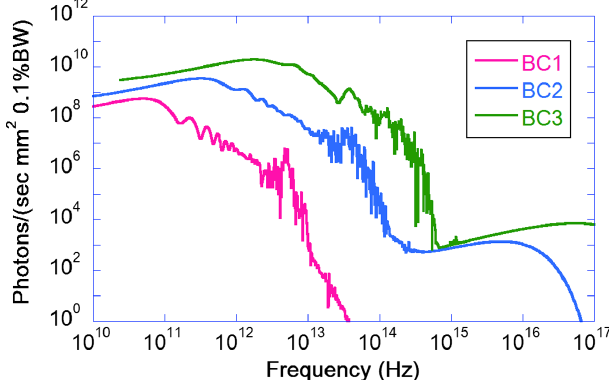
FIG. 20. Numerical calculations of the CSR intensities depen- dent on the wavelength at BC1, BC2, and BC3. Calculations clearly show that the CSR intensities increase, while the fre- quency increases.